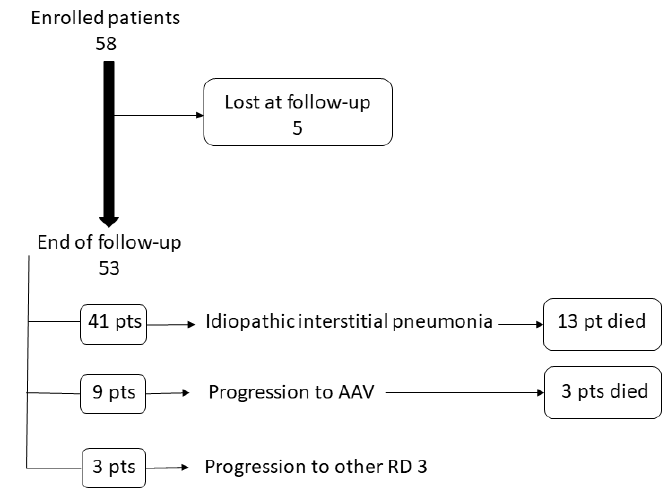
Figure 1. Clinical evolution of patients enrolled in the study.